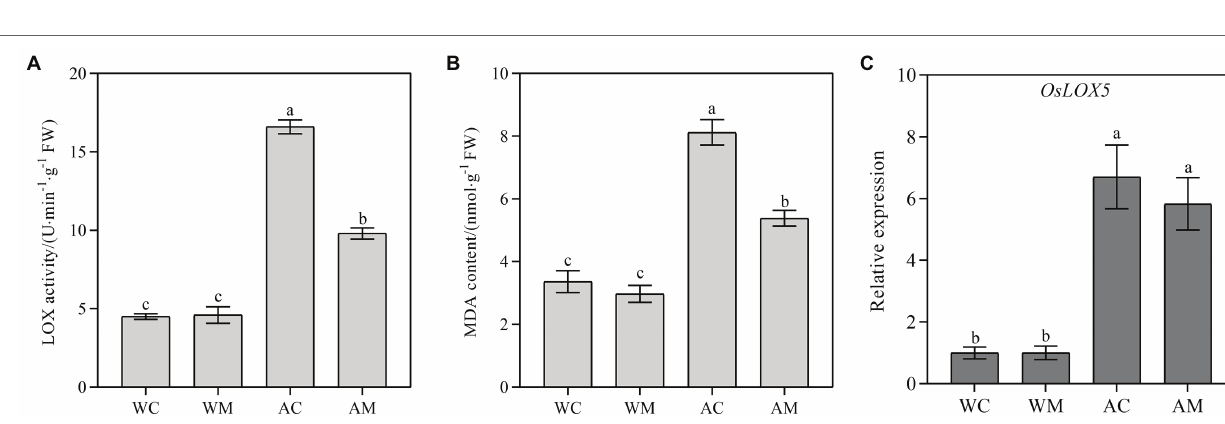
FIGURE 4 | Effects of exogenous MT on lipoxygenase (LOX) activity, malondialdehyde (MDA) content, and OsLOX5 expression. (A) LOX activity; (B) MDA content; and (C) Relative expression level of OsLOX5 gene. Data represent means ± SEs of three replicate samples. Different letters denote significant differences ( n = 3, and p < 0.05). WC, control; WM, control pretreated with MT; AC, alkaline stress; and AM, alkaline-stressed plants pretreated with